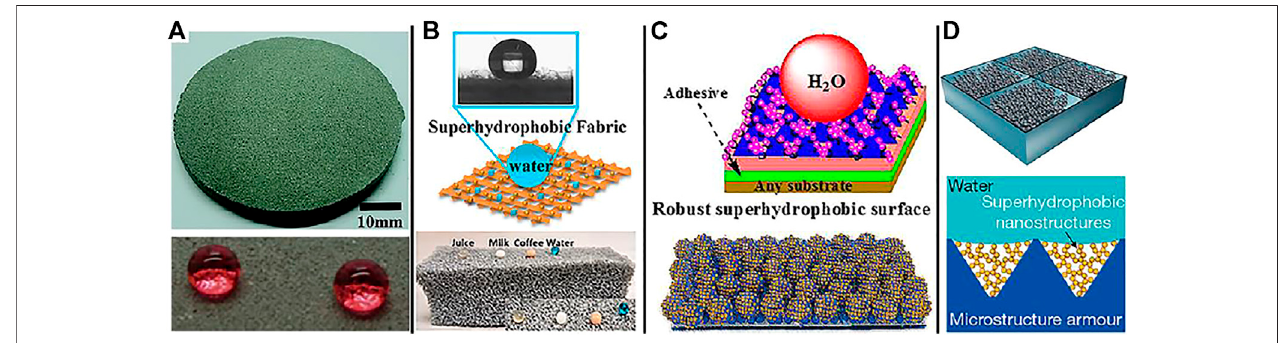
FIGURE 2 | Mechanical superhydrophobic models: (A) Self-hardness: the surface of cement (Song et al., 2017a). (B) Porous materials: the surface of textile and sponge (Shang et al., 2020; Ozkan et al., 2020). (C) “ Paint + adhesive ” method (Qing et al., 2019; Zhu et al., 2020). (D) Schematic diagram of a strategy to enhance the mechanical robustness of superhydrophobic surfaces by containing hydrophobic nanostructures in protective microstructures “ armor ” (Wang et al.,